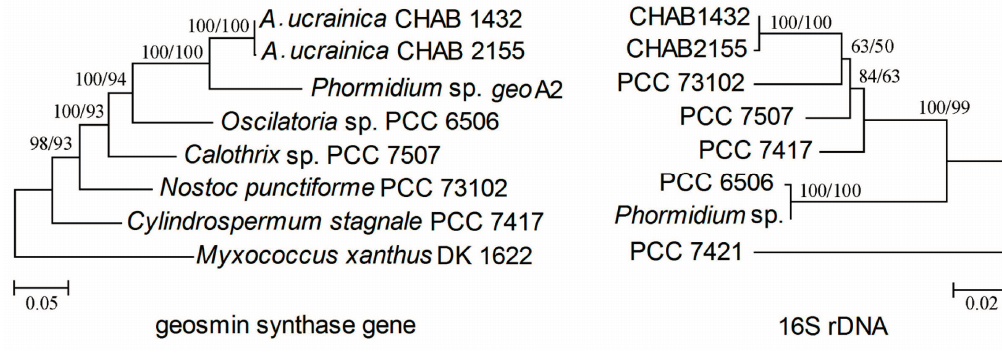
Figure 5. Comparison between the topologies of the geosmin synthase gene (2248 bp)